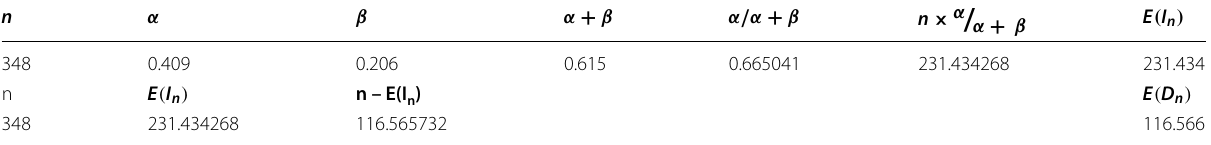
Table 7 Expected total number of monthly increase and decrease in share prices. Source: Authors computation with data generated from NSE n